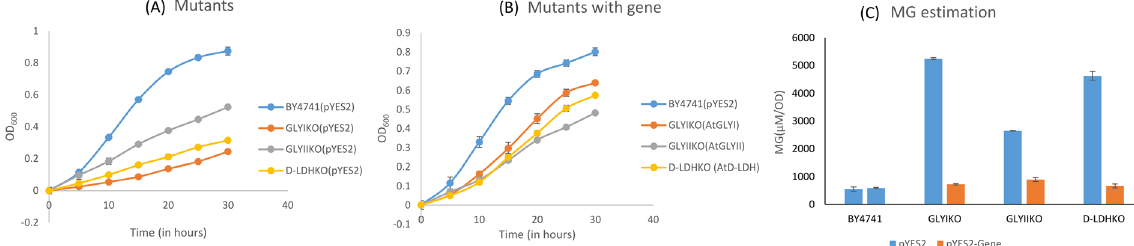
Figure 5. Stress tolerance assay in yeast mutants of MG detoxification enzymes in MG detoxification: BY4741 wild type yeast cells, GLYIKO, GLYIIKO and D-LDHKO mutant yeast cells containing empty vector pYES2 were grown in presence of exogenous MG ( A ). These mutant cells were transformed with their respective mutant genes cloned in pYES2 vector and the complemented yeast cells were grown in presence of exogenous MG stress and their growth was monitored along with wild type BY4741 cells ( B ). MG levels were estimated in all of these samples after 30 hours and contribution of these genes in detoxification of MG was compared.